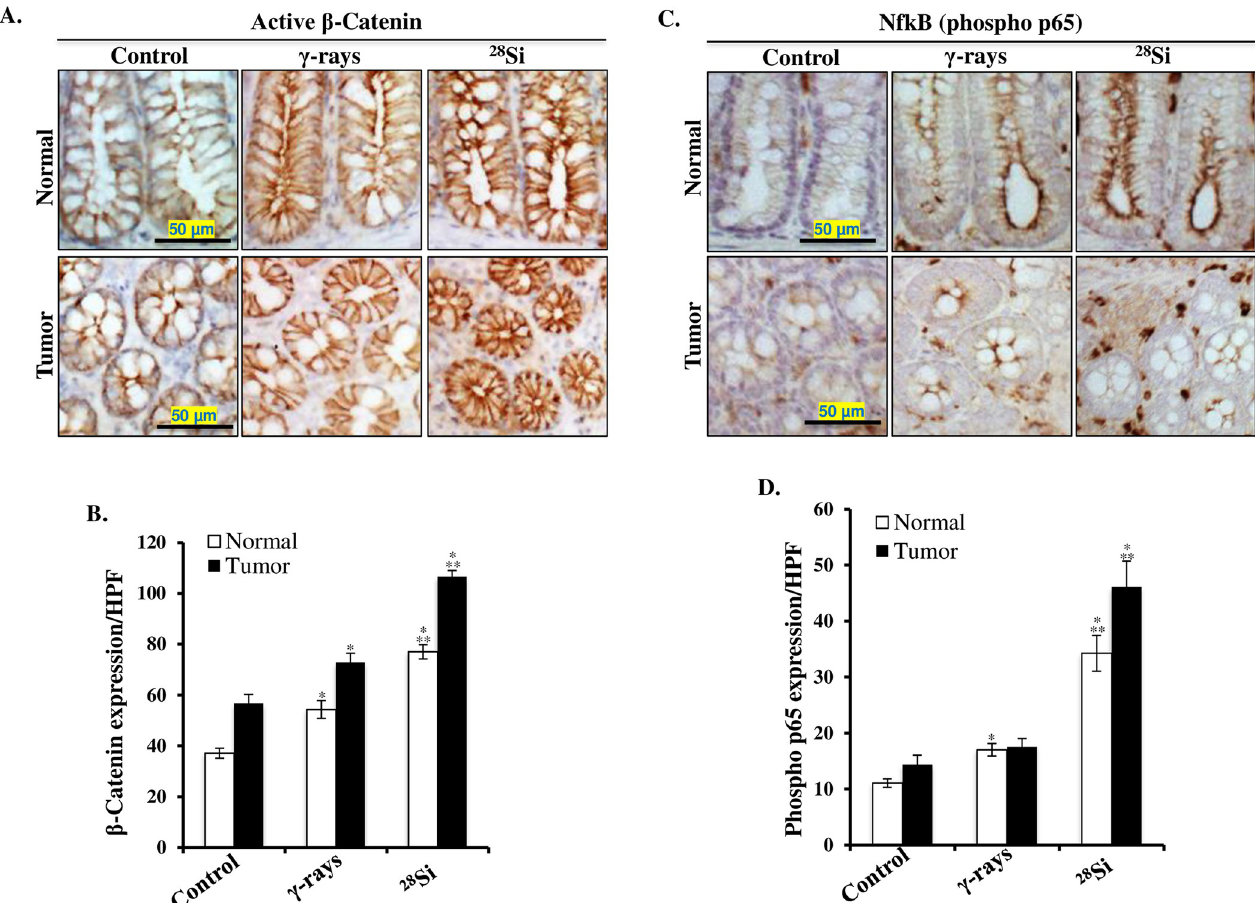
Fig 4. Increased activation of β -catenin and NF- κ B in heavy-ion exposed mouse colon. A) Representative images (200X) of active β -catenin-stained tumor- free (normal) and tumors from control, γ -rays, and 28 Si irradiated mice. B) Quantification of active β -catenin staining measured as DAB intensity per high- powered microscopic field (HPF) in normal and cancer tissues. C) Representative images (200X) of phospho-p65 (NF- κ B) stained tumor-free (normal) and tumors from control, γ -rays, and 28 Si irradiated mice. D) Quantification of phospho-p65 staining measured as DAB intensity per HPF in normal and tumor tissues. All bars show mean ± SEM and � indicates a p value < 0.05 compared to control and �� indicates p < 0.05 compared to the γ exposed group.